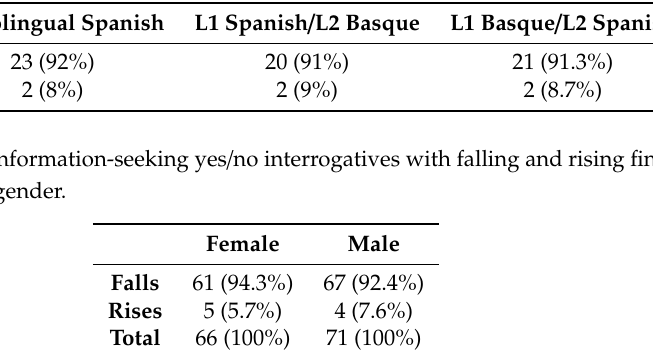
Table 4. Numbers and percentages of information-seeking yes / no interrogatives with rising–falling and rising final contours (Falls and Rises, respectively) for each linguistic profile in the town of Ibarra.